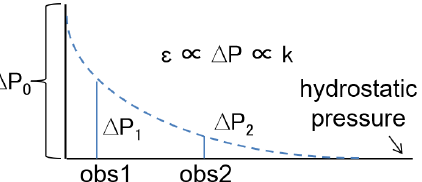
Figure 7. Schematic illustration of spatial strain ( ε ) due to changes in pore pressure ( (cid:49)P ). The latter is controlled by permeability ( k ) of formation